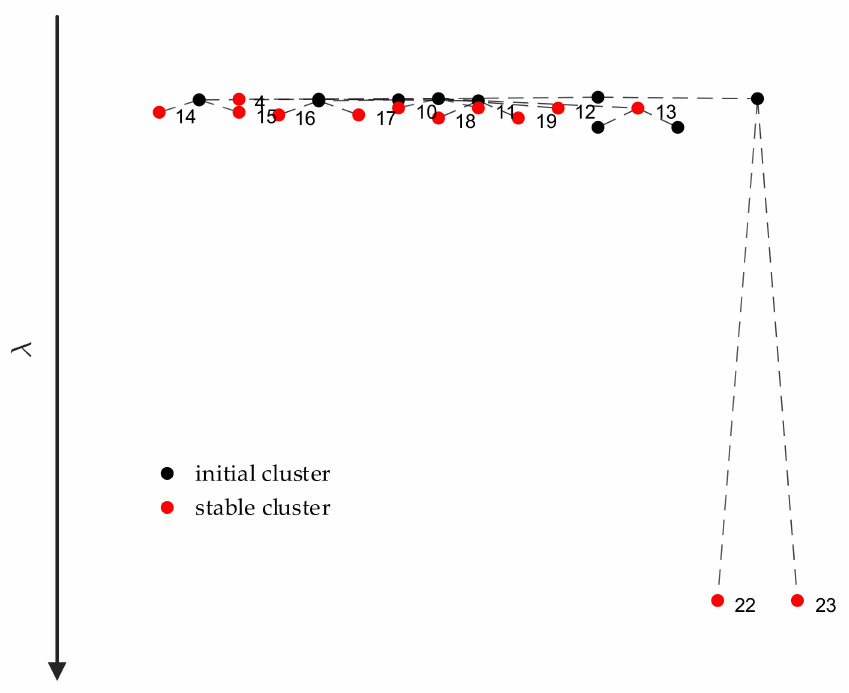
Figure 11. The schematic diagram of the condensed cluster tree for sheath current matrix of the MV cable circuit.